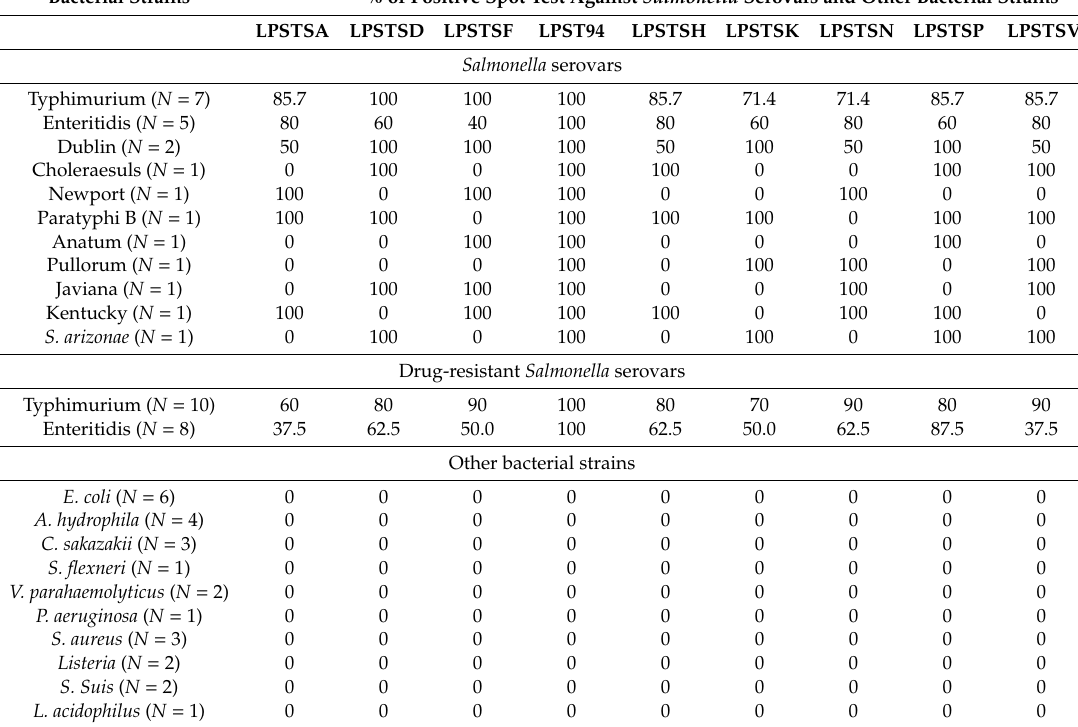
Table 1. Sensitivity of di ff erent Salmonella serovars and other bacterial strains against selected phages determined by spot